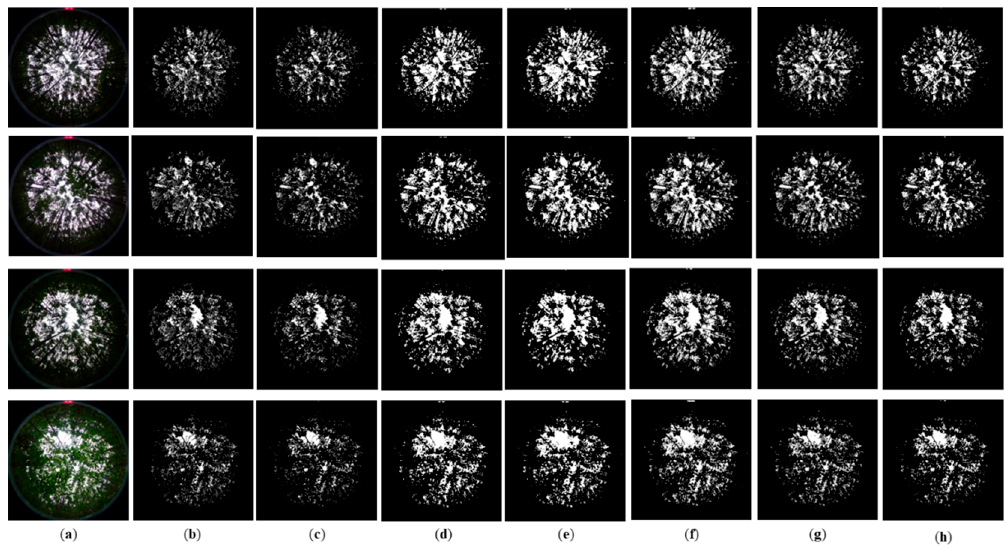
Figure 7. Comparison of segmentation results for six different methods: ( a ) Original canopy hemispherical photography (CHP) images; ( b ) manually extracted reference images, segmentation results obtained from ( c ) newly developed U-net method as well as from ( d ) Otsu; ( e ) Ridler; ( f ) fuzzy clustering method (FCM); ( g ) WinSCANOPY; ( h ) Habitat-Net methods.